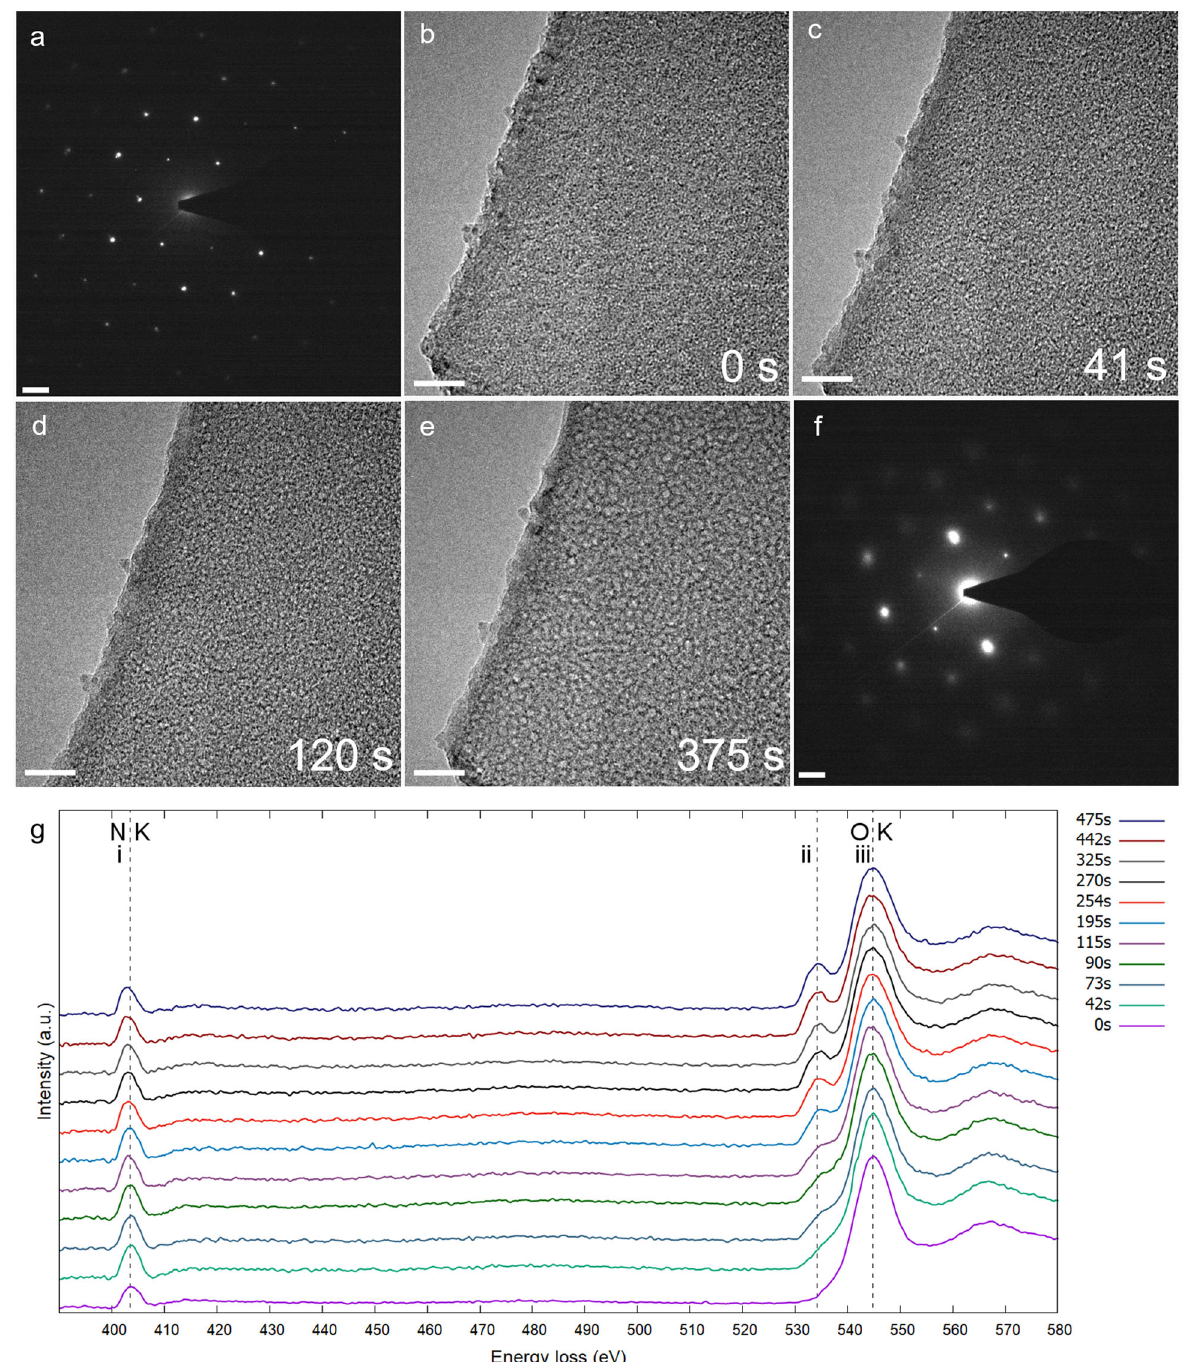
Fig. 5 Electron irradiation of Ni – Fe LDH at 300 kV at cryogenic temperatures. a , f Depict electron diffraction patterns of Ni – Fe LDH before and after irradiation experiments. b – e BFTEM series images during 300 kV irradiation when the sample is cooled to − 180 °C in situ. Time-series core loss EELS spectra of the nitrogen K edge and oxygen K edge acquired from 0 to 475 s in ( g ). The time associated with the individual spectra indicates the electron irradiation time of the Ni – Fe LDH sample. Scale bars are 2 nm − 1 for the SAED patterns and 20 nm for the BFTEM micrographs